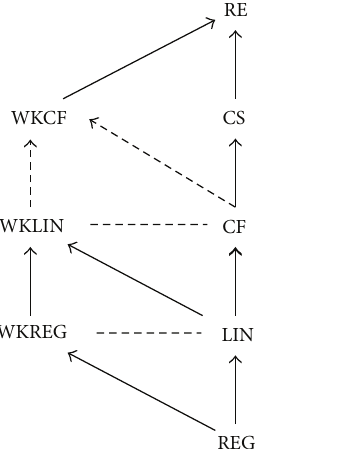
Figure 4: The hierarchy of WK and Chomsky language